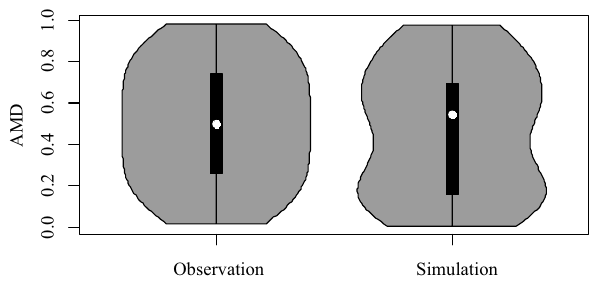
Fig. 8 Results of generating the AMD series in test step using copula- GARCH approach